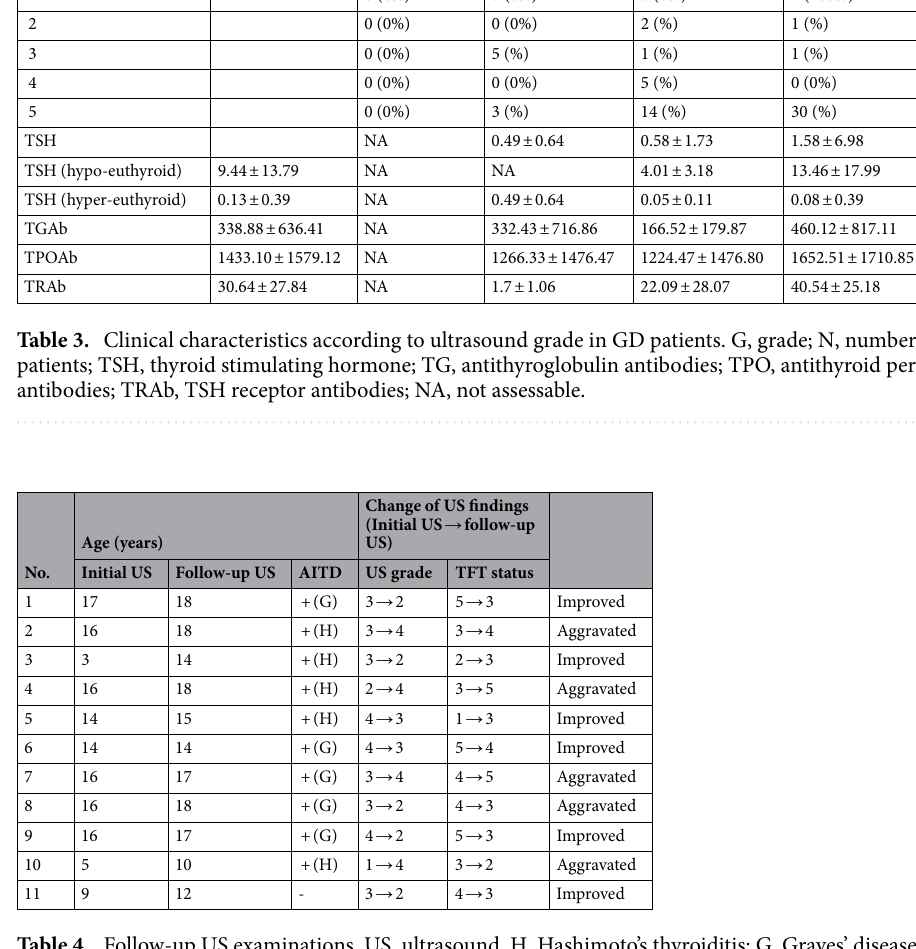
Table 4. Follow-up US examinations. US, ultrasound, H, Hashimoto’s thyroiditis; G, Graves’ disease.